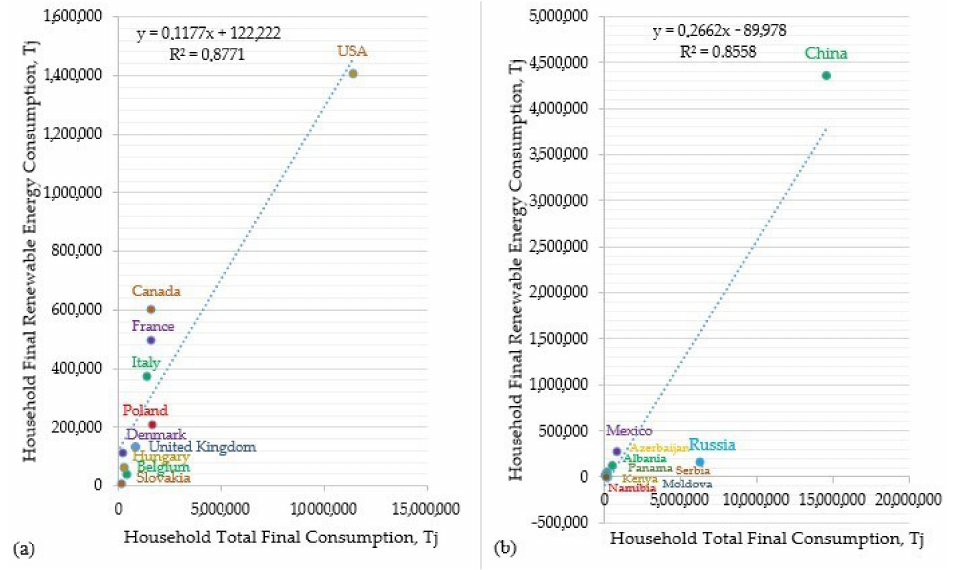
Figure 1. Dependence of total energy consumption and consumption of energy from renewable sources by households in the studied developed ( a ) and developing ( b ) countries. Source: generated by the